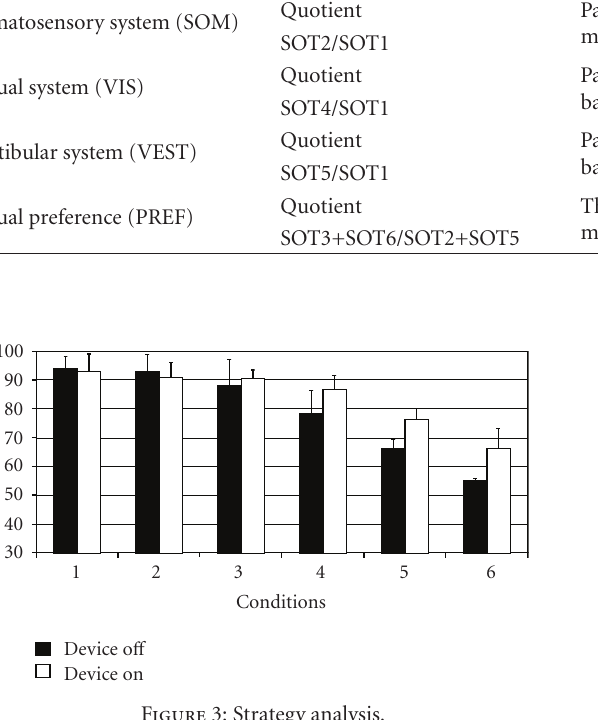
Figure 4: Sensory analysis of the overall test